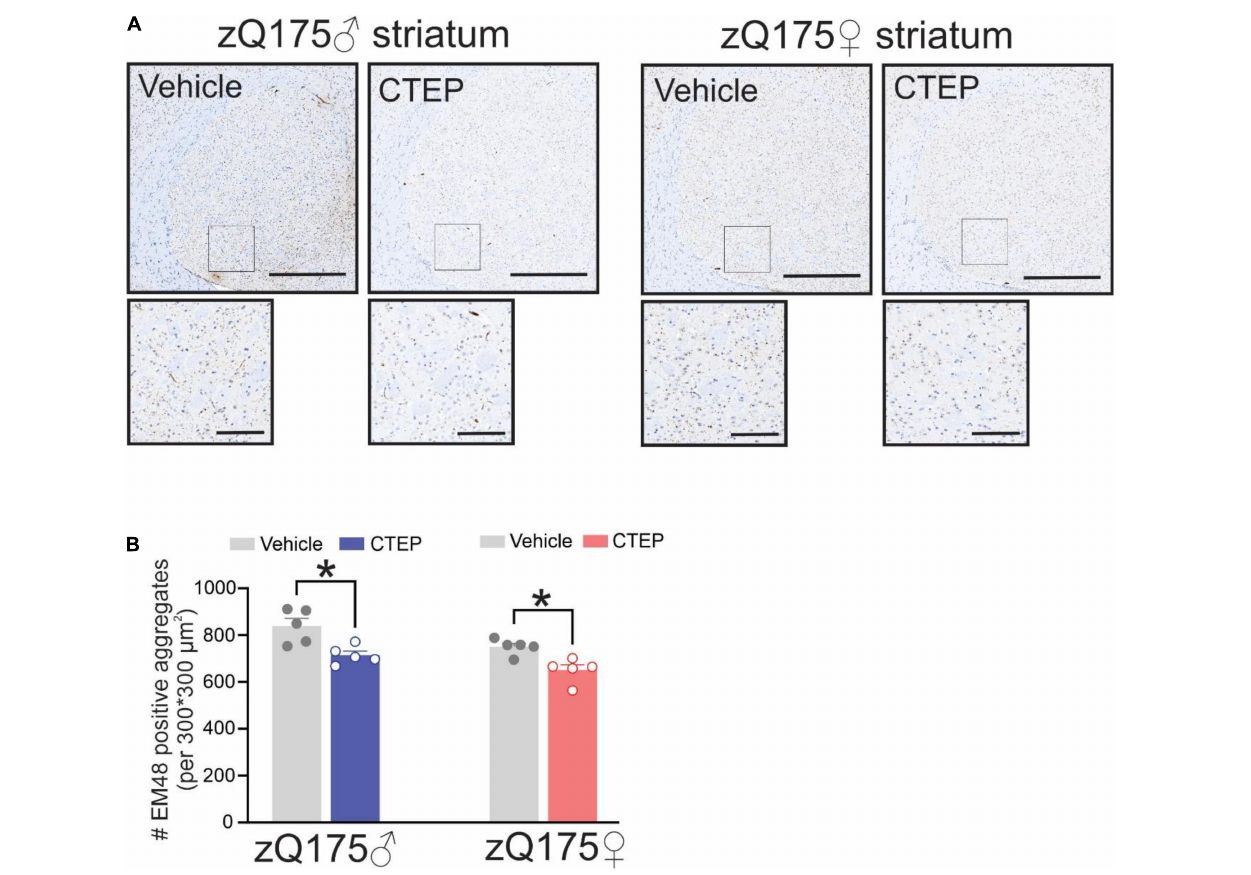
FIGURE 4 | Effect of chronic administration CTEP on mutant huntingtin aggregates in male and female zQ175 mouse striatum. Representative images of staining for mHtt aggregates using the antibody EM48 (A) and quantification of the number of huntingtin aggregates (B) in striatal brain slices from 15-month-old male and female heterozygous zQ175 mice after 12 weeks of treatment with either vehicle or CTEP (2 mg/kg/48 h). Scale bar = 500 µ m for whole striatum and 100 µ m for magnified areas. Data are quantified from two different 300 × 300 µ m 2 striatal regions of 6 sections per mouse and five independent mouse brains from each group were used for analysis. Data are mean ± SEM. * P < 0.05 by two-way analysis of variance (ANOVA) and Tukey’s multiple comparisons